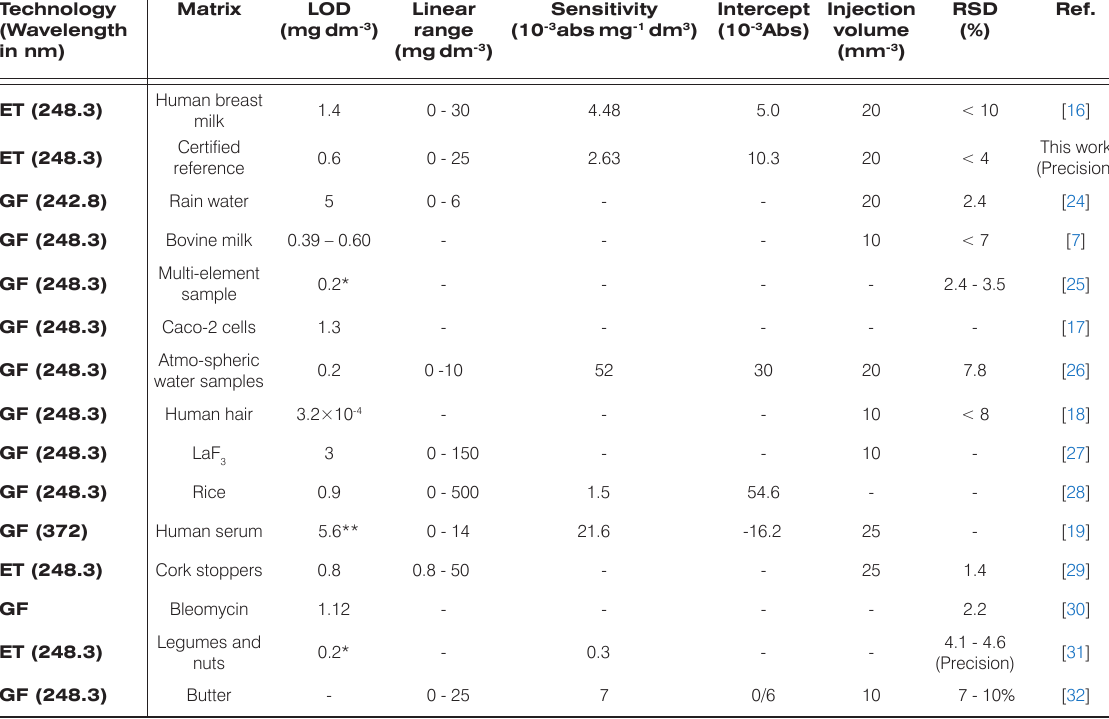
Table 1. Figure of merits that are associated with determination of iron by electrothermal AAS (ETAAS)/GFAAS (Ordinary wavelength 248.3